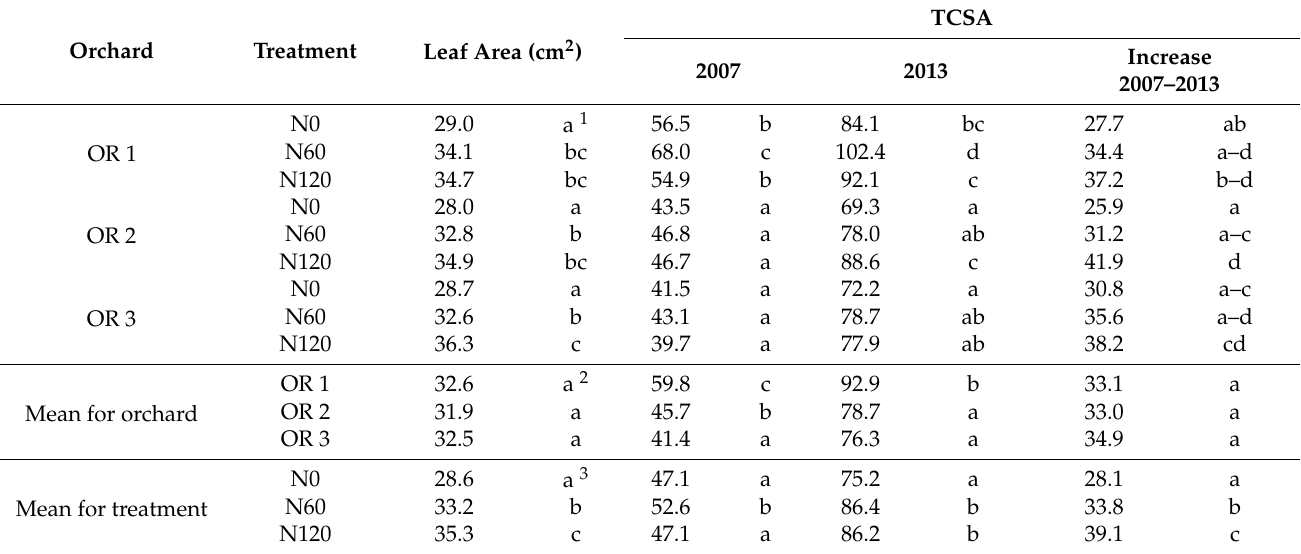
Table 8. The influence of nitrogen fertilization on cherry growth in